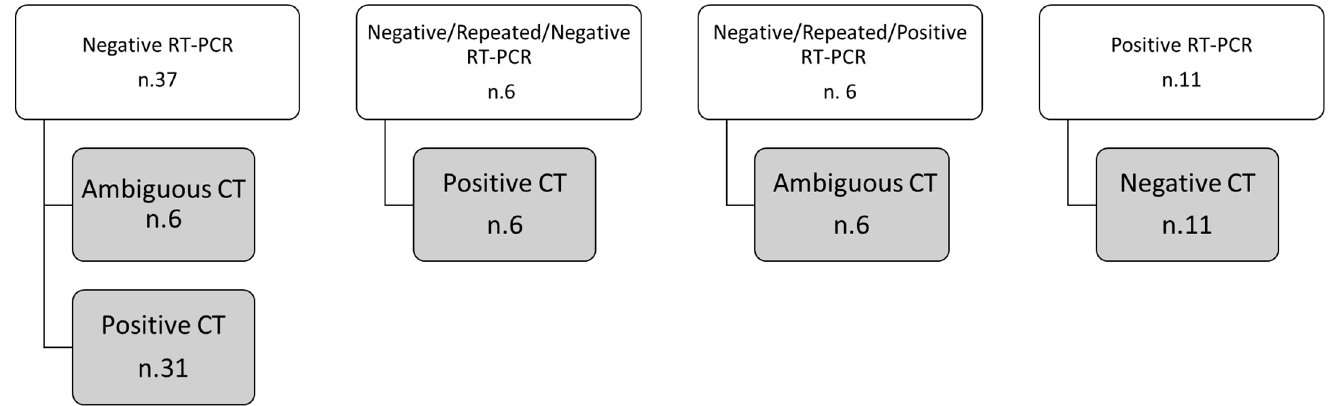
Figure 1. Schematic diagram of patients with discordant findings between RT-PCR test and CT.